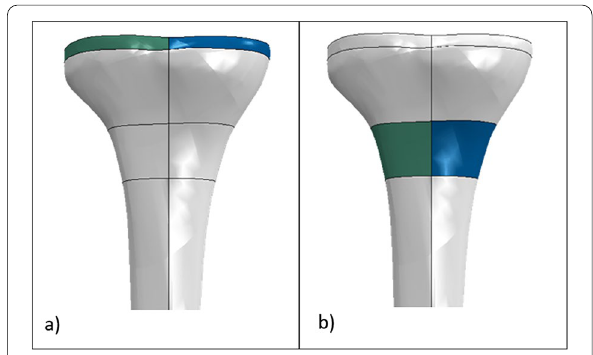
Fig. 4 Regions of interest in the tibia (green and blue represent respectively the lateral and medial regions), posterior view; ( a ) proximal tibia regions; ( b ) distal tibia regions